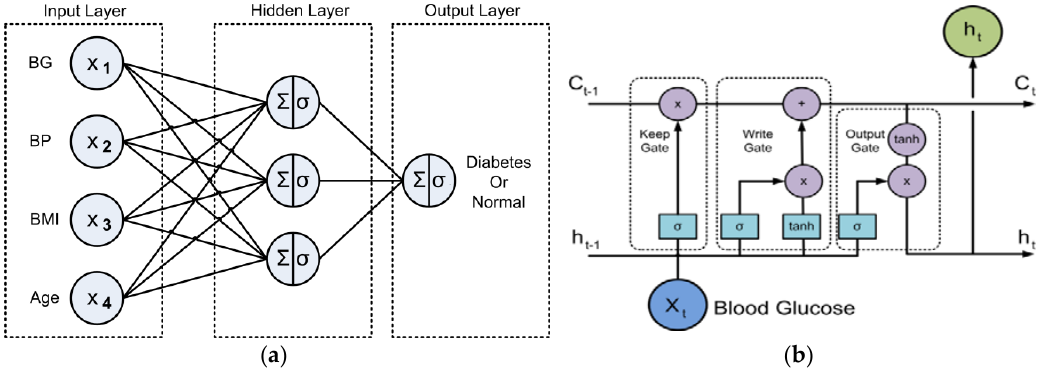
Figure 6. ( a ) The Multilayer Perceptron (MLP) architecture for diabetes classification and ( b ) BG prediction based on Long Short ‐ Term Memory ( LSTM).